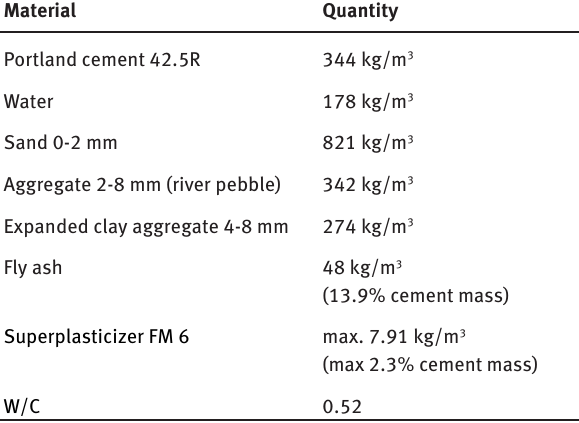
Table 1: Initial concrete mix design.